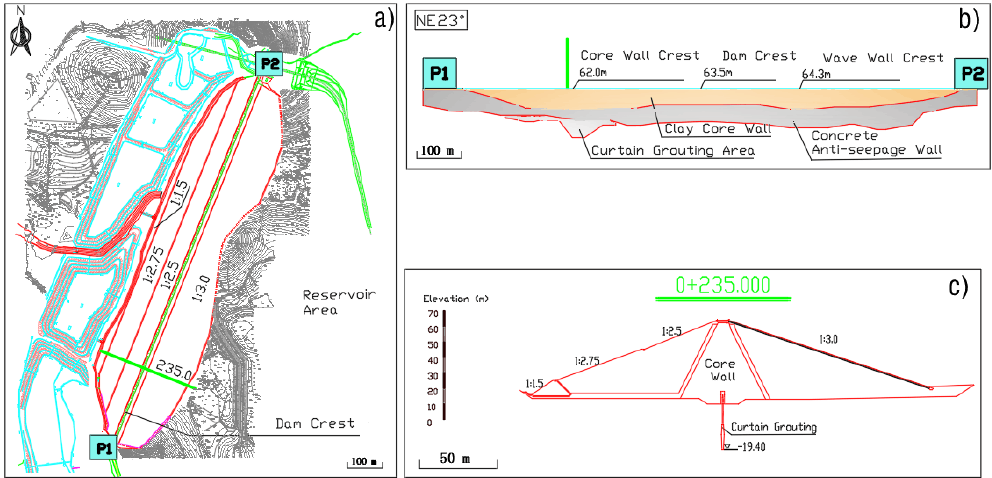
Figure 5. ( a ) A contour Map of the Gongming No. 4 dam; ( b ) a longitudinal axis profile map between P1 and P2; ( c ) a transect map at 235 m.